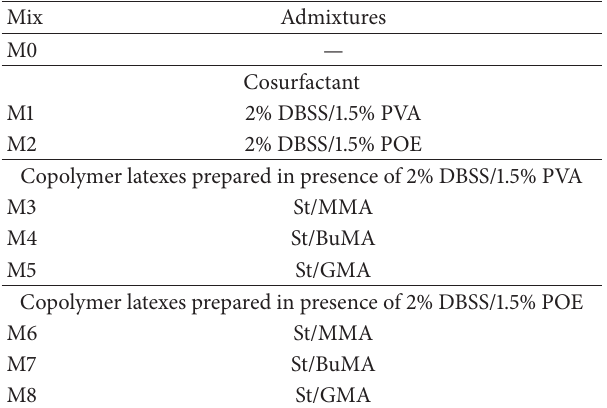
Table 3: Admixtures used in mortar